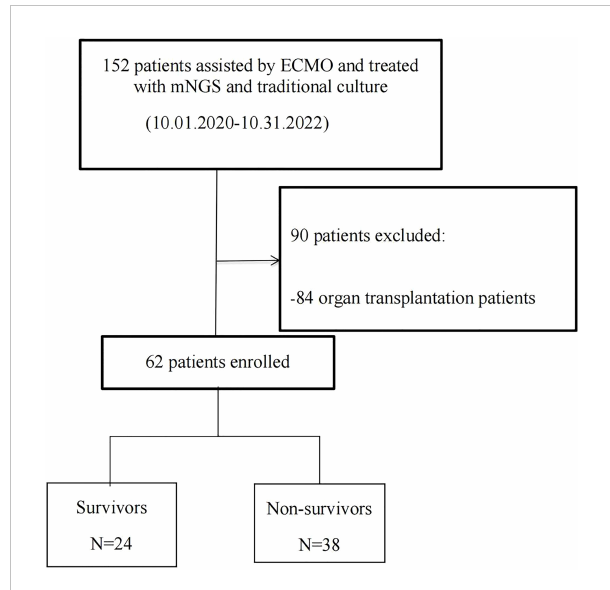
FIGURE 1 Flowchart of analyzed patients. ECMO, extracorporeal membrane oxygenation; mNGS, metagenomic next-generation sequencing.